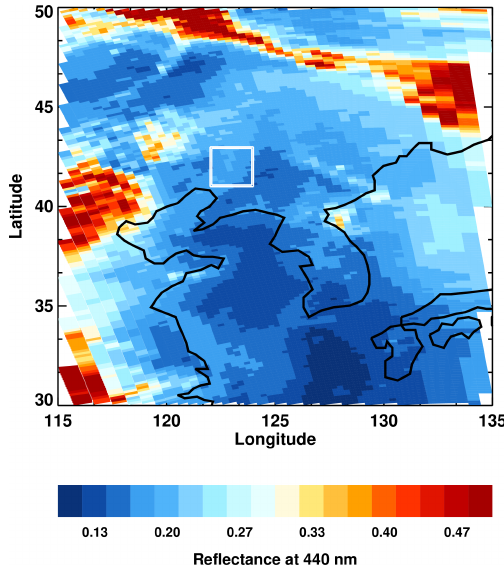
Figure 4. TOA reflectance at 440nm over northeastern China for OMI orbit 3843 on 5 April 2005. The selected cloud-free region is denoted by a